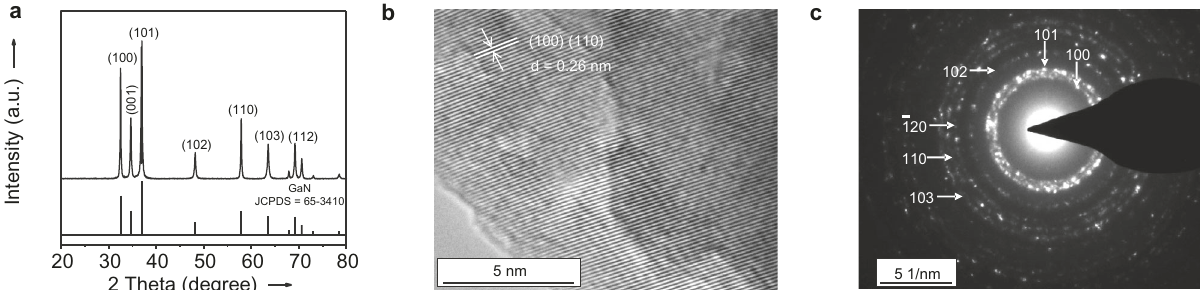
Fig. 2 Structural characterizations of the GaN-26.6 catalyst. a X-ray diffraction pattern. b Transmission electron microscopy image. c Selected area electron